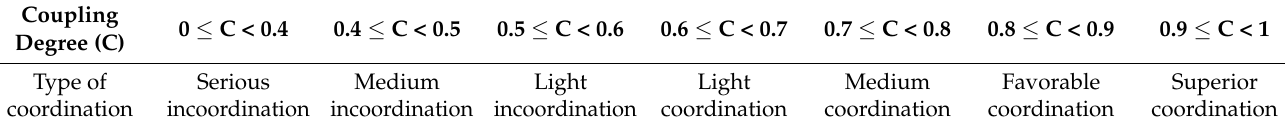
Table 2. System of ecosystem coupling